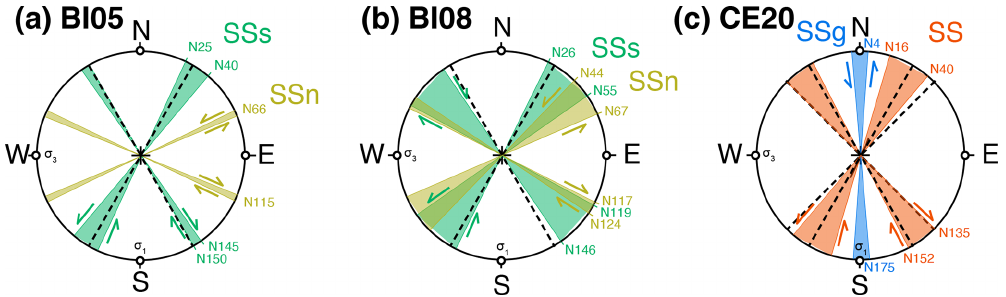
Figure 9. Stereo plots showing the ranges of orientations and the relative motion of strike-slip faults located in the northern (SSn) and southern (SSs) parts of (a) model BI05 and (b) model BI08 , after a total of around 10% of E–W stretching (see Fig. 4), and (c) in the underformed (SS) and previously deformed (SSg) parts of model CE20 (right) after 5% of stretching (see Fig. 6). The black dotted lines indicate angles of 30 ◦ (for the three models) and 45 ◦ (for the brittle–ductile model CE20) with respect to a N–S σ 1